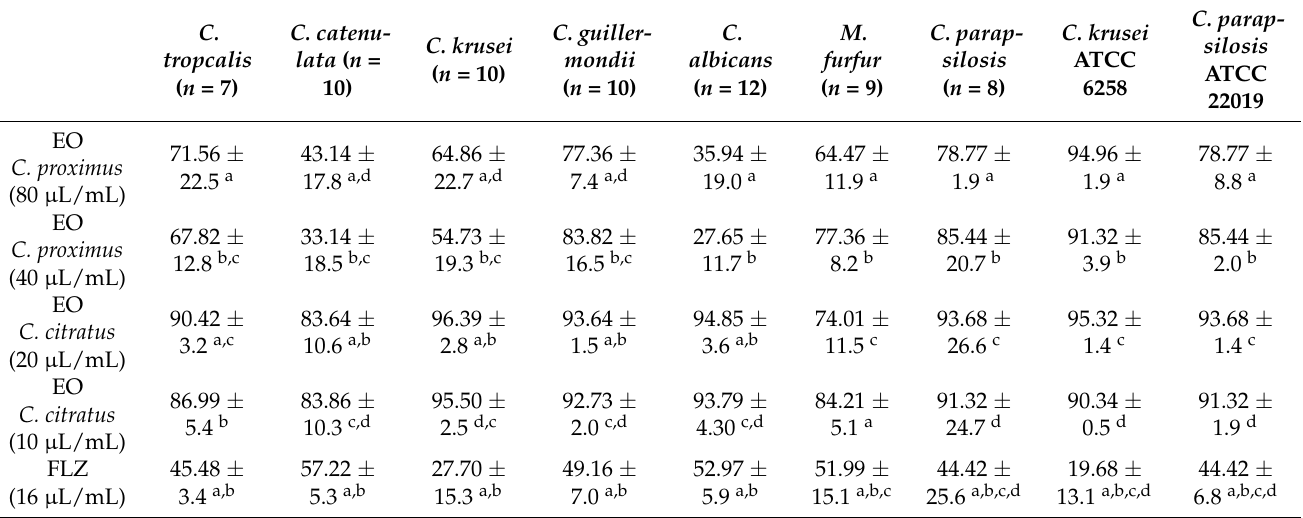
Table 4. Percentage of Candida spp. and Malassezia furfur biofilm inhibition by C. proximus and C. citratus EOs at different concentrations.